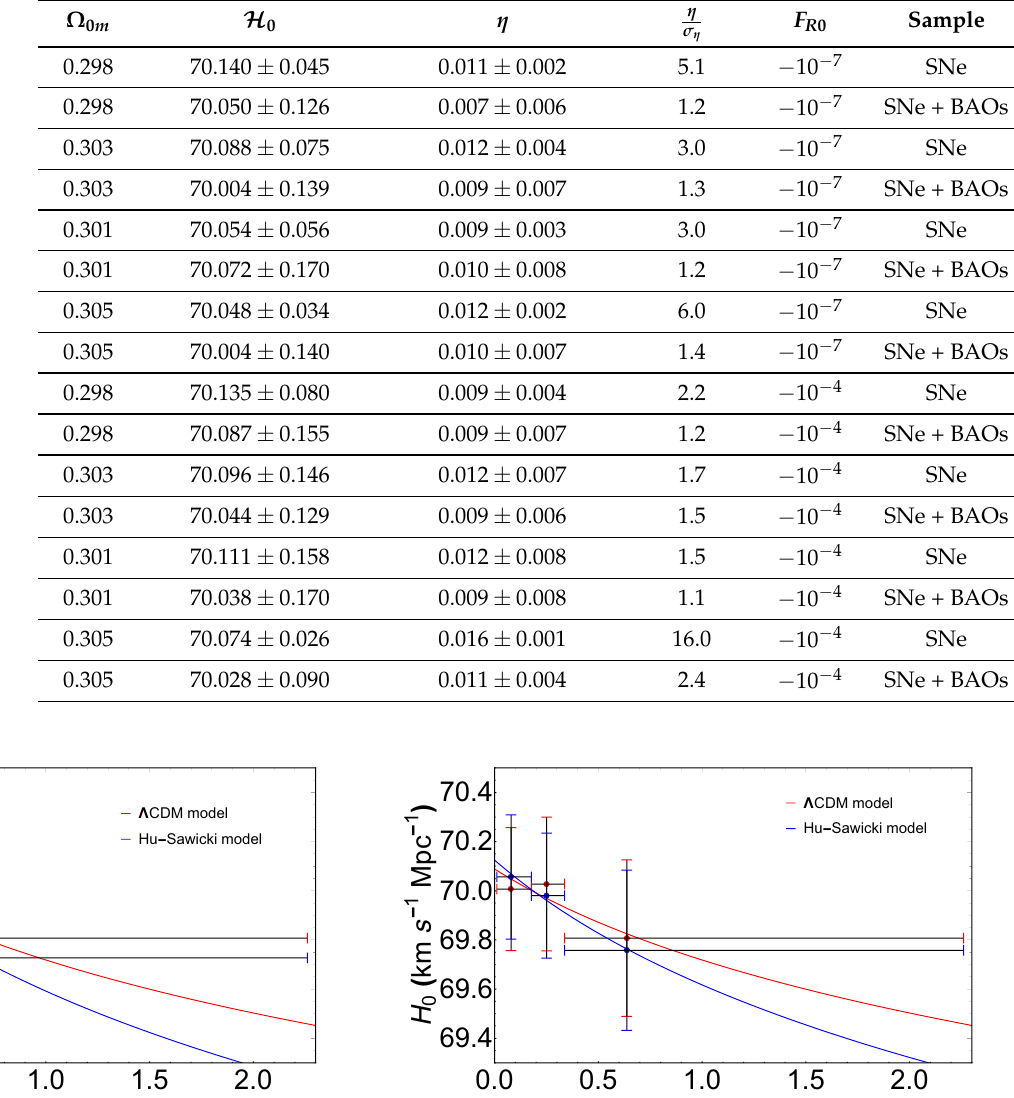
Table 3. Fitting parameters of H 0 ( z ) for three bins within the Hu–Sawicki model, with SNe and SNe + BAOs by fixing several values of Ω M = 0.298,0.303,0.301,0.305 and values of F R 0 = − 10 − 4 and F R 0 = − 10 − 7 . The columns are as follows: (1) the Ω 0 m value; (2) H 0 , (3) η , according to Equation